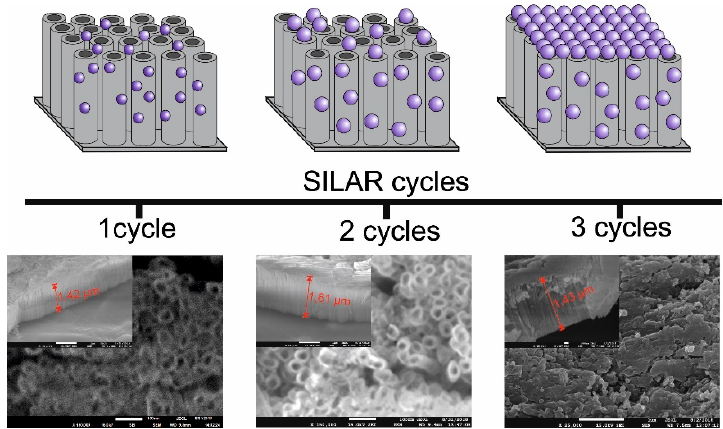
Figure 4. Scanning electron microscope (SEM) images and schematic representation of the surface of nanotube arrays (NTs) modified by quantum dots (QDs).